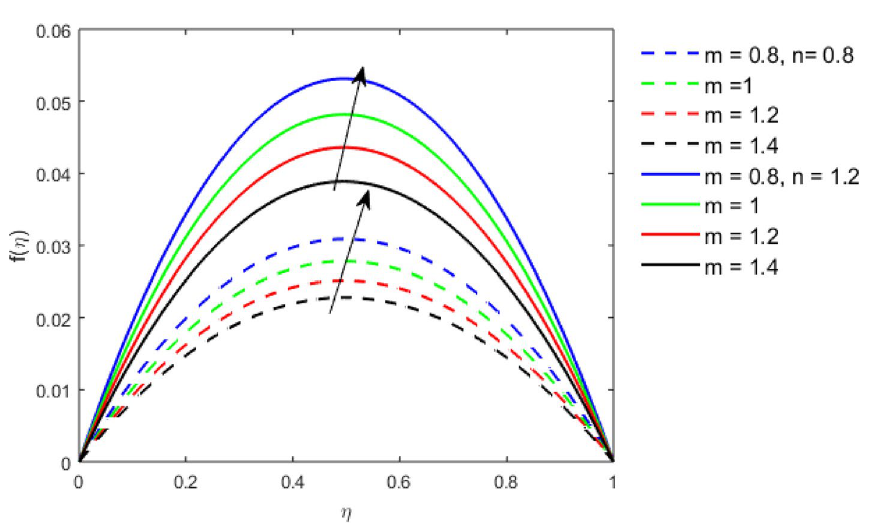
Figure 6. The Radial velocity profile for increasing thickness index m of disk for Pseudoplastic and dilatant